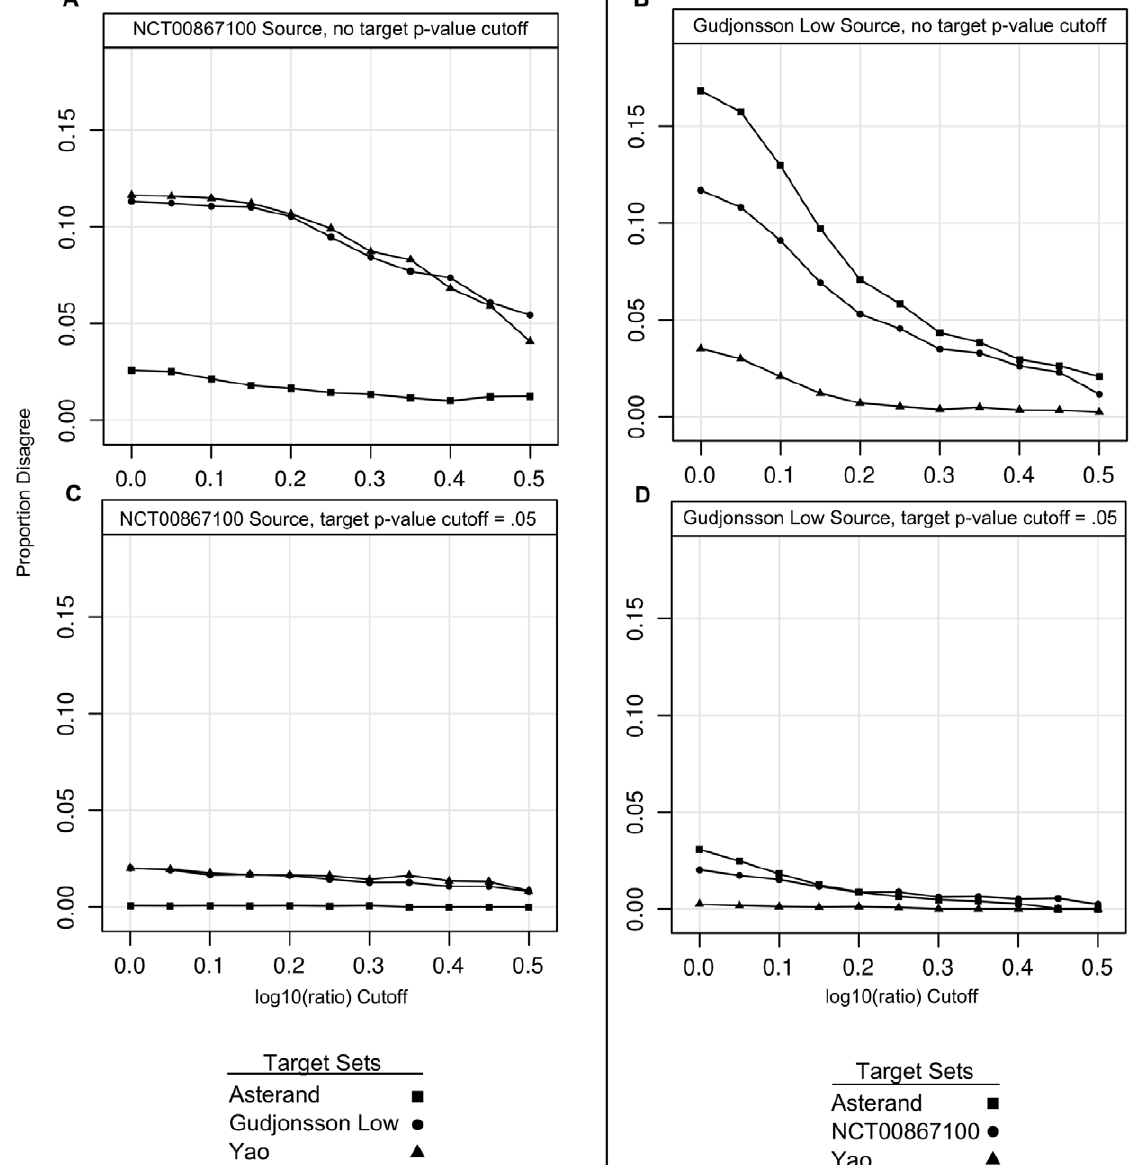
Figure 3. Effect of log10(ratio) on Proportion of ‘‘Disagreeing’’ Probe Sets at a p-value of 0.05 in the Source Set. The data sets are the same as for the data shown in Figure 1. Either NCT00867100 (A, C) or Gudjonsson Low (B, D) were chosen as the source set. The proportion of probe sets disagreeing (out of all the probe sets) is shown for different log10(ratio) cutoffs. A and B: p-value of 0.05 in the source set and no cut-offs in the target sets; C and D: p-value cut-off of 0.05 in source and target set.